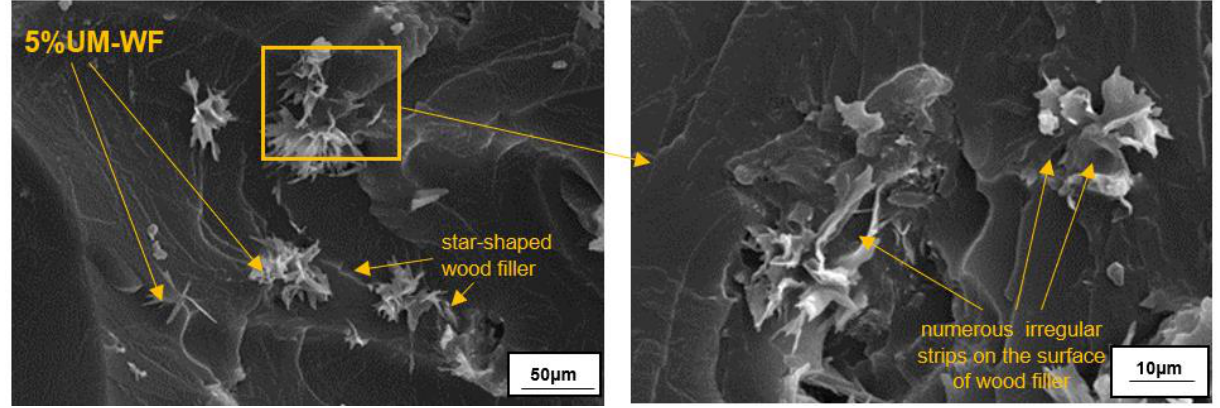
Figure 9. SEM micrographs of the impact fracture surface of the crosslinked sample of ESBO_BPA composition filled with 5 wt % of unmodified wood flour.